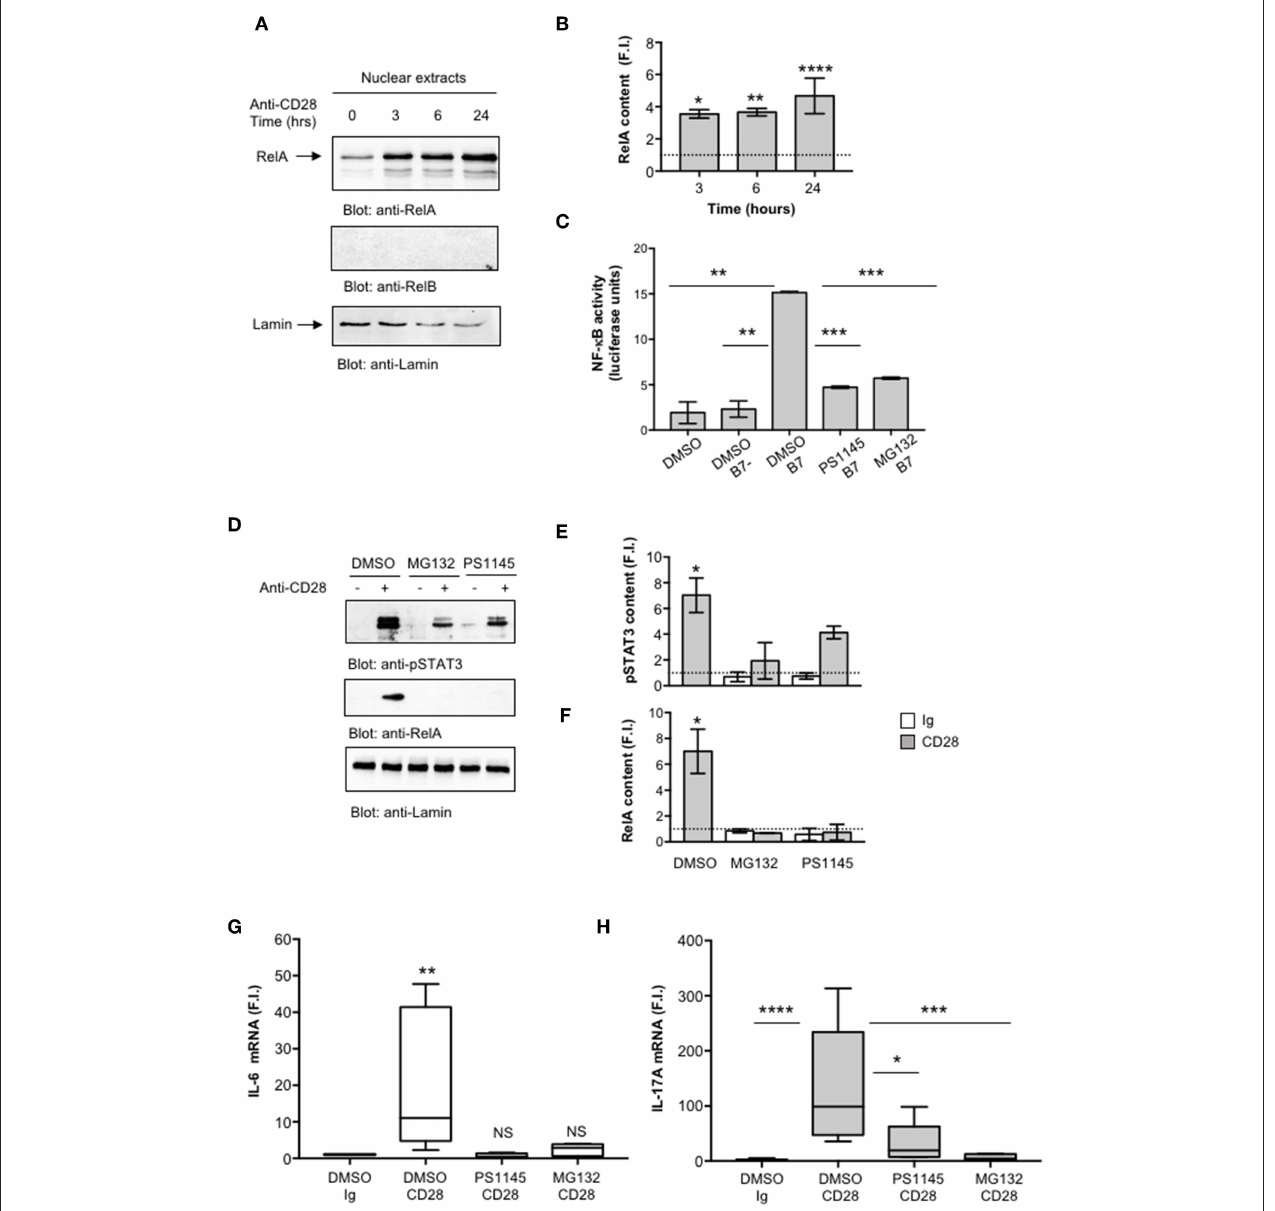
FIGURE 4 | CD28-activated NF- κ B regulates IL-17A expression. (A) CD4 + T cells were stimulated for the indicated times with isotype control Ig or anti-CD28.2 Abs and RelA and lamin B1 levels in nuclear extracts were analyzed by western blotting. (B) RelA fold inductions (F.I.) were quantified by densitometric analysis and normalized to lamin B levels. Bars represent mean F.I. ± SEM of two HD. Significance was calculated by Student t -test. * p < 0.05, ** p < 0.01, **** p < 0.000.1 (C) NF- κ B luciferase activity of Jurkat cells treated with DMSO, as vehicle control, or 5 µ M MG132 or 10 µ M PS1145 and stimulated for 6h in the absence or presence of Dap3 (B7-) or Dap3/B7 cells (B7). The results are expressed as the mean of luciferase units ± SD after normalization to GFP values. The data are representative of three independent experiments. Significance was calculated by Student t -test. ** p < 0.01, *** p < 0.001. Mean values ± SD: DMSO = 1.9 ± 1.1, DMSO B7 = 2.3 ± 0.9, DMSO B7 = 15.15 ± 0.12, PS1145 B7 = 4.72 ± 0.11, MG132 B7 = 5.71 ± 0.11. (D) Western blotting of pSTAT3, RelA, and lamin A/C levels in nuclear extracts of CD4 + treated with DMSO, as vehicle control, or PS1145, or MG132 and stimulated for 6h with isotype control Ig or anti-CD28.2 Abs. pSTAT3 (E) and RelA (F) fold inductions (F.I.) were quantified by densitometric analysis and normalized to lamin B levels. Bars represent mean F.I. ± SEM of three HD. Significance was calculated by Student t -test. * p < 0.05. (G,H) IL-6 (G) and IL-17A (H) mRNA levels of CD4 + T cell from HD ( n = 5) untreated or treated with DMSO, as vehicle control, or PS1145, or MG132 and stimulated for 6h (G) or 24h (H) with isotype control Ig or anti-CD28.2 Abs. The values were normalized to GAPDH and fold inductions (F.I.) over isotype control Ig-stimulated cells were calculated. Lines represent median values and statistical significance was calculated by Mann-Whitney test. * p < 0.05, ** p < 0.01, *** p < 0.001, **** p < 0.0001. Median values: IL-6, DMSO Ig = 1, DMSO CD28 = 11, PS1145 CD28 = 0.4, MG132 CD28 = 2.8; IL-17A, DMSO Ig = 1, DMSO CD28 = 98.8, PS1145 CD28 = 19.4, MG132 CD28 =